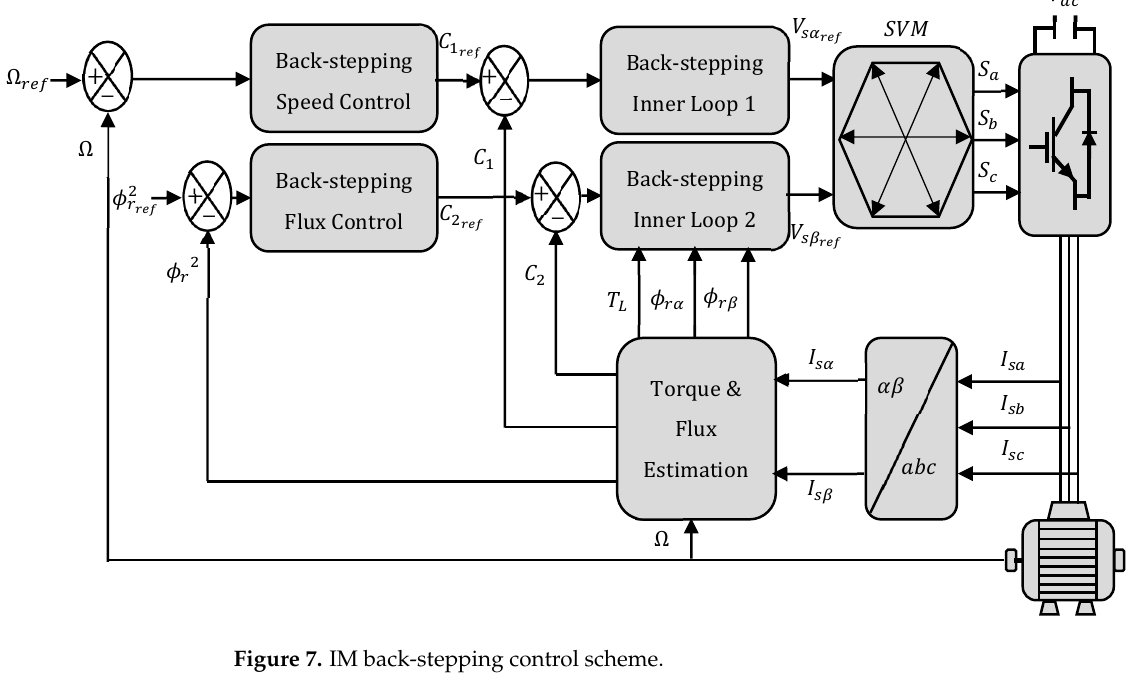
Figure 7. IM back ‐ stepping control scheme.